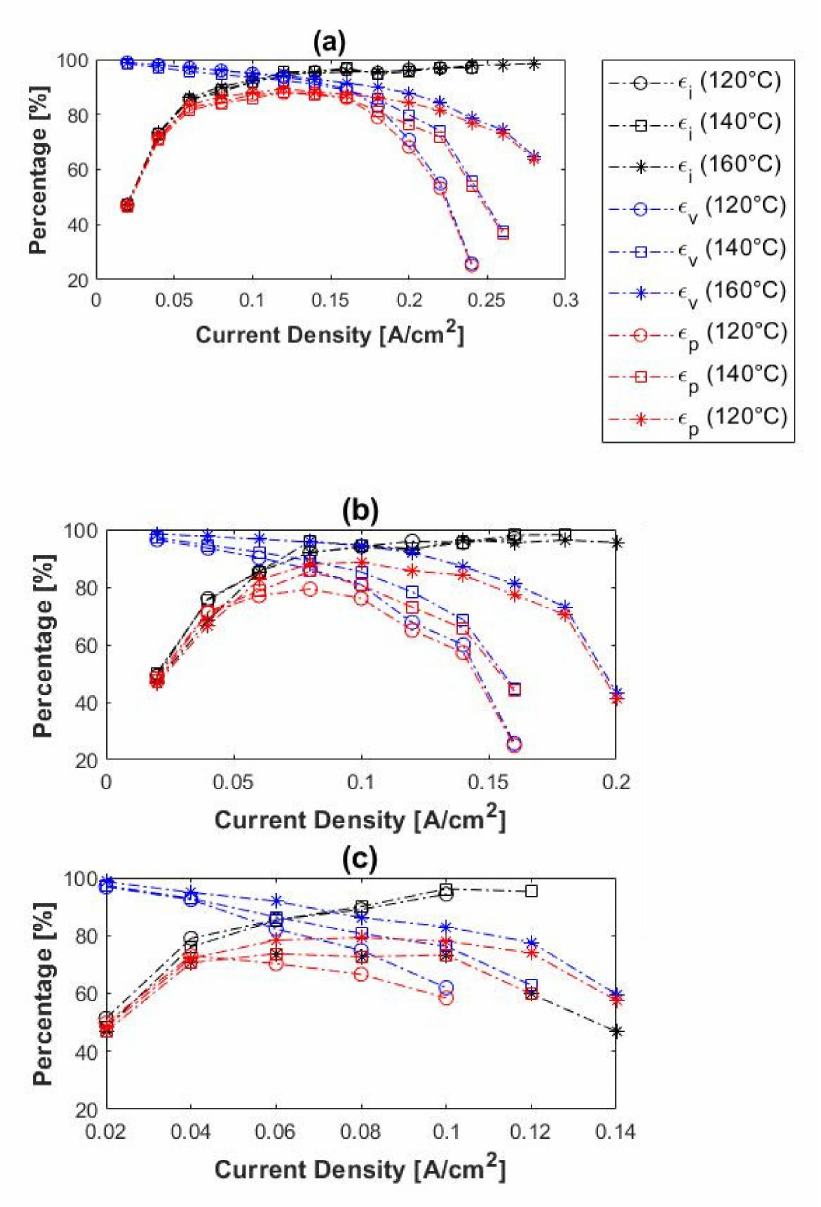
Figure 9. Current-( ε i ), voltage-( ε v ), and power ( ε p ) efficiencies as a function of current density at 120–160 ◦ C for ( a ) 10%, ( b ) 50%, and ( c ) 80% methane, balance hydrogen (hydrogen flow rate = 100 mL n /min, 1